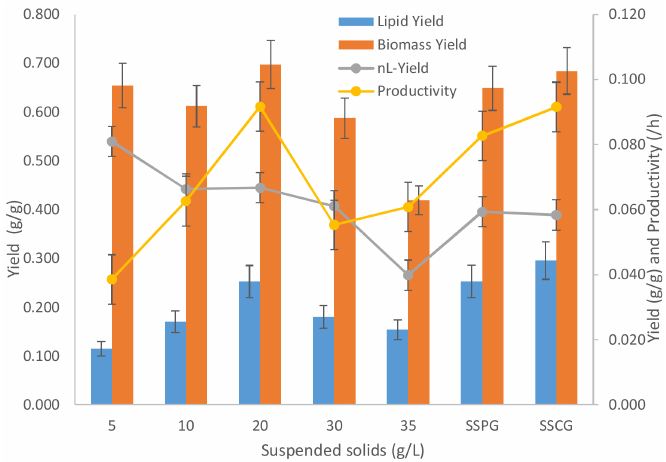
Figure 6. Yields and productivity comparison for flask fermentations at different sludge solid